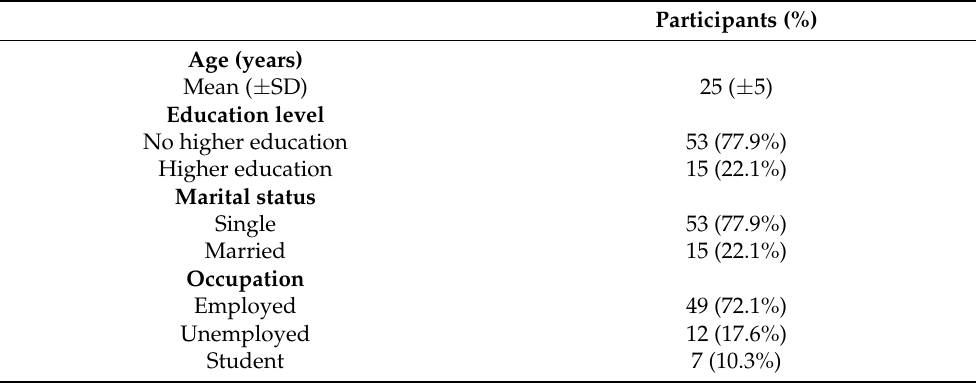
Table 1. The male players’ sociodemographic characteristics (n =